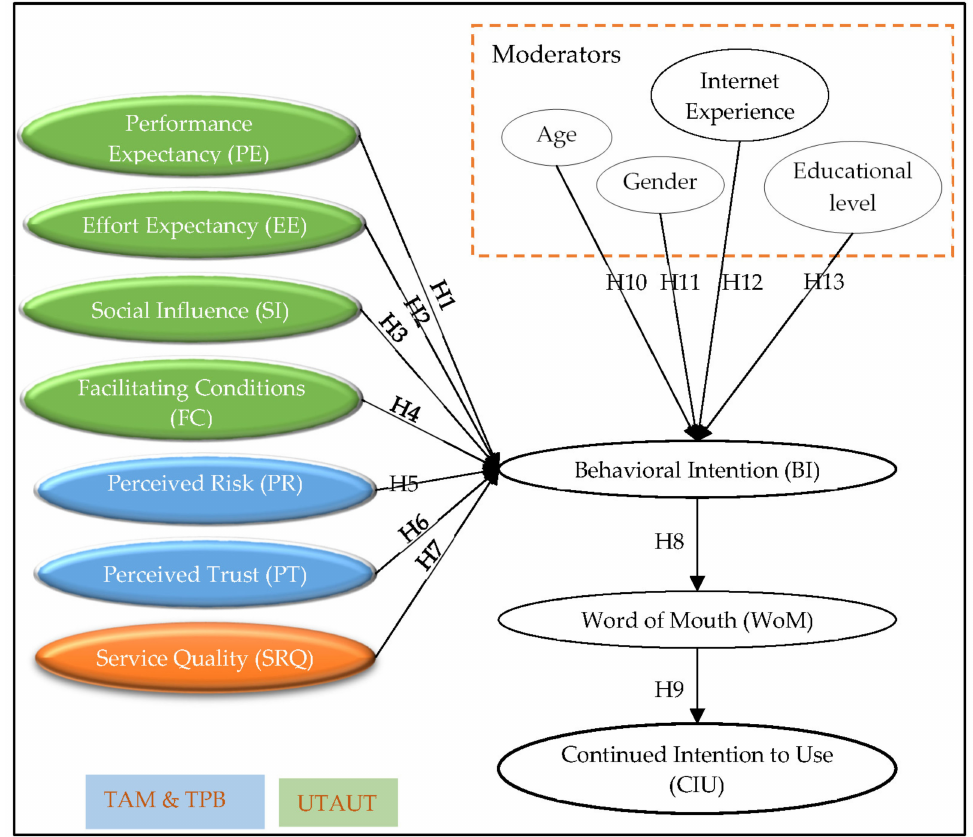
Figure 1. The proposed model of m-Banking continued intention to